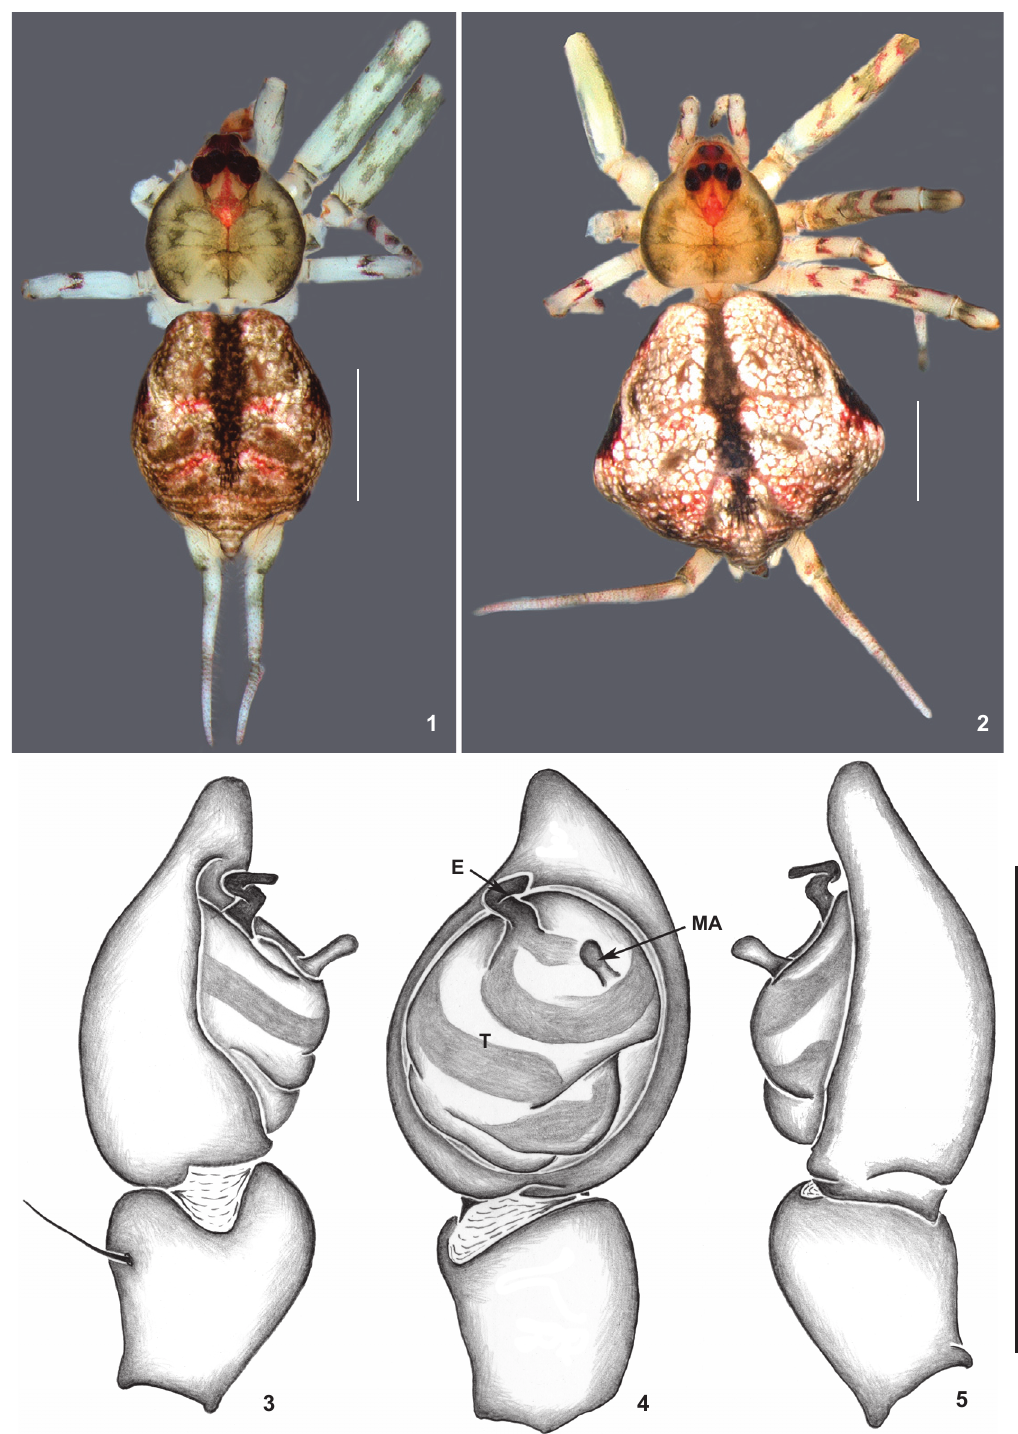
3 Figures 1-5. Yabisi guaba. (1-2) Habitus, dorsal view: (1) male; (2) female. (3-5) Male, left palp: (3) prolateral view; (4) ventral view; (5) retrolateral view. (E) Embolus, (MA) median apophysis, (T) tegulum. Scale bars: 1-2 = 1 mm, 3-5 = 0.5 mm. ZOOLOGIA 31 (4): 405–407, August, 2014